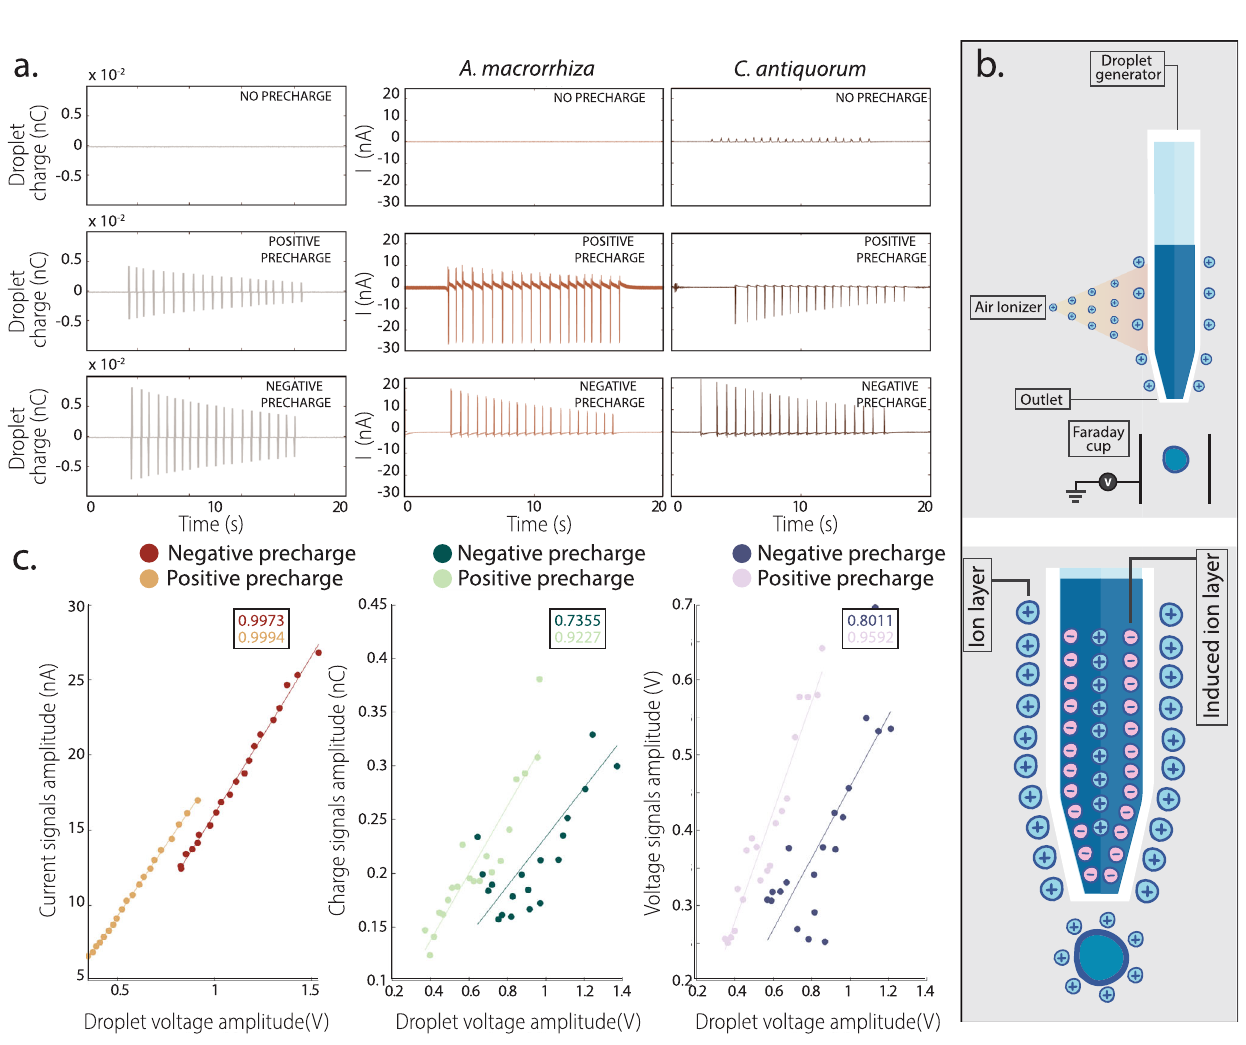
Fig. 4 Effect of droplet pre-charging on the signals generated in A. macrorrhiza and C. antiquorum . a Table of graphs showing the droplet charge before leaf impact ( fi rst column), current signals measured in A. macrorrhiza (second column) and C. antiquorum (third column). The fi rst row corresponds to no pre-charge condition, the second to positive pre-charge and the third to negative pre-charge. Each electrical variable was measured thrice per leaf, for a total of 60 droplets and signals; results of 20 droplets are representatively shown. b Schematics showing the setup (upper panel) and the mechanism (lower panel) of droplet pre-charging by pipette ionization. c Scatter plots illustrating the relationship between the droplet signal in the Faraday cup and the current, charge, and voltage amplitudes in C. antiquorum . Each point corresponds to a single droplet impact in a series of twenty sequential impacts. The insets give the correlation coef fi cients between the droplet voltage signal measured in the Faraday cup and the corresponding current, charge or voltage; a linear fi t for each set is included.